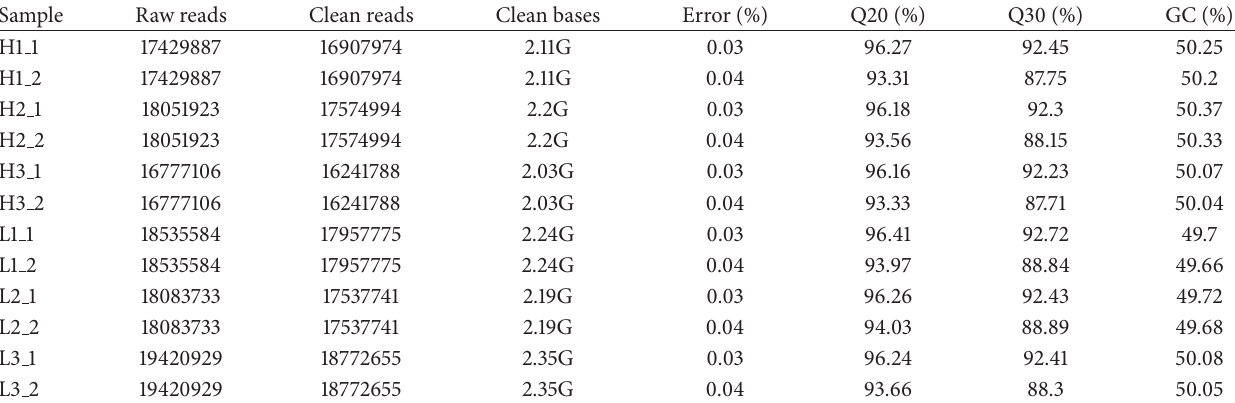
Table 2: The descriptive statistics of the raw RNA-seq datasets for all of the six individuals sequenced in the present study. Sample